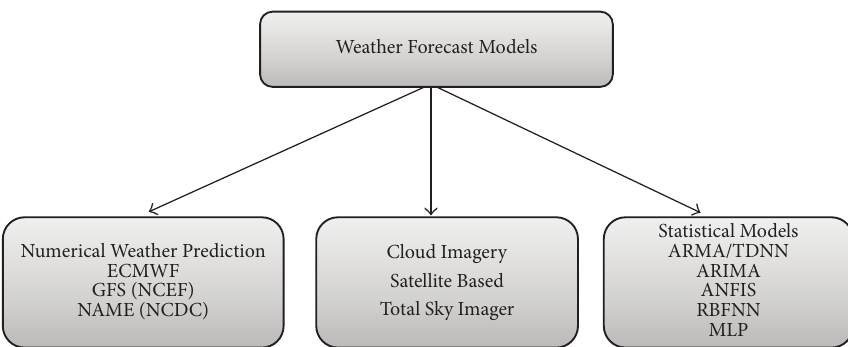
Figure 4: Classification of weather forecasting models, adopted from